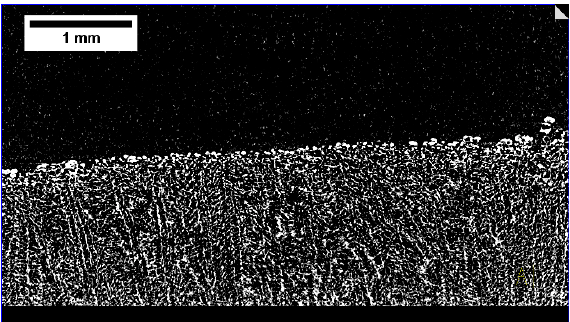
Figure 6. Sectional view of a dried 5% (w/w) sucrose solution.